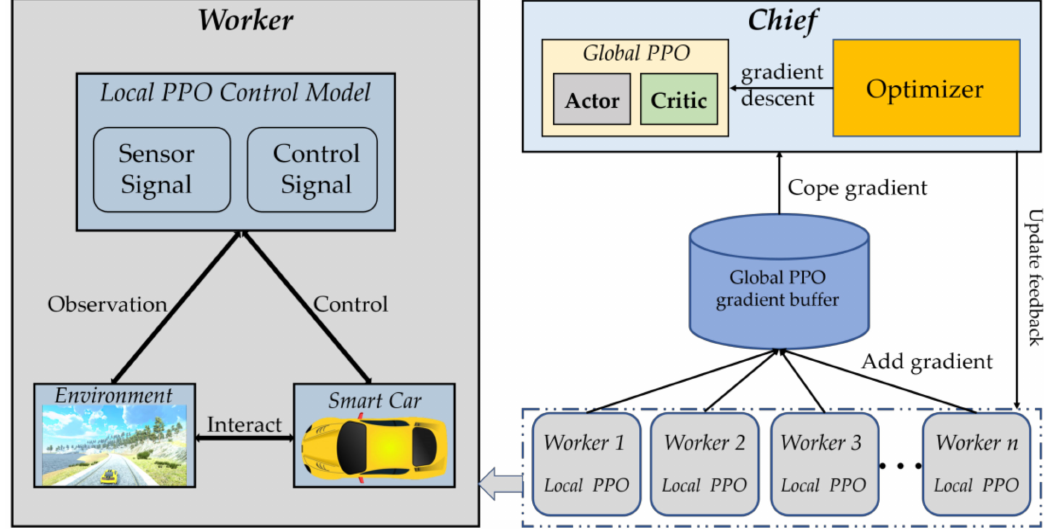
Figure 3. DPPO multithreaded processing framework.